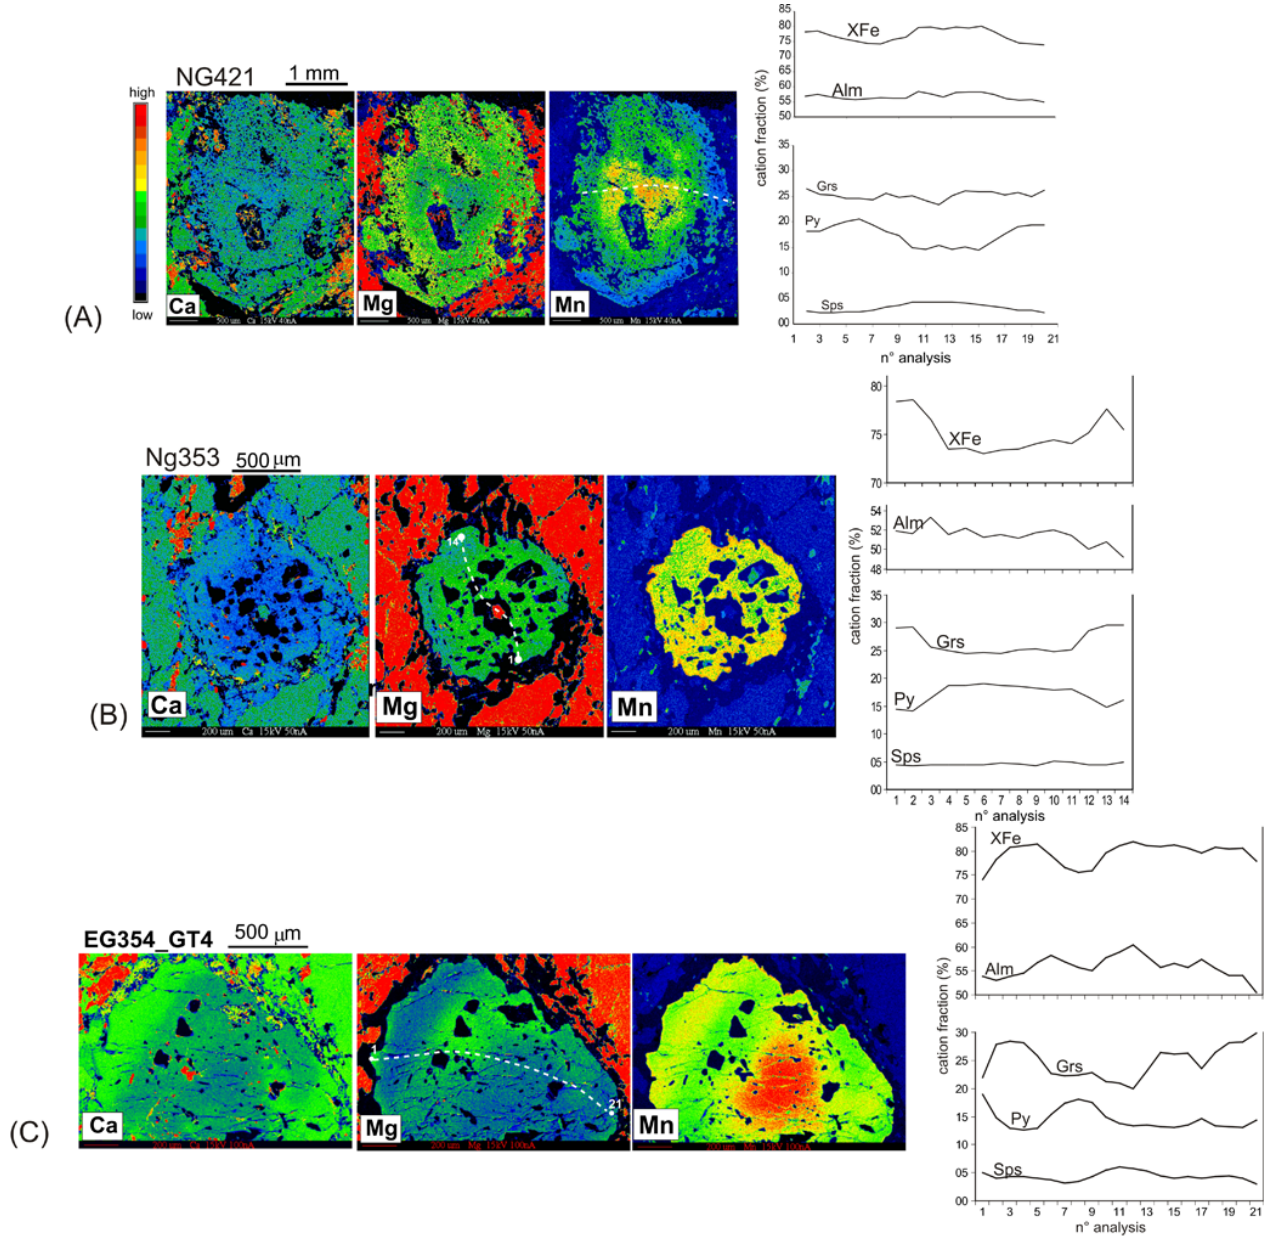
Fig. 9. Left: representative qualitative compositional cation map and quantitative cation profiles showing the variation in cation (Mg, Fe, Ca, Mn) distribution in garnets from the Sabzevar granulites. Noteworthy features are the rimward increase in Ca (grossular) and Mn (spessartine, Sps) and decrease in Mg (pyrope), which are indicative of retrograde diffusion and resorption. Alm, almandine; Grs, grossular; Py, pyrope; Sps, spessartine. Right: garnet compositions as obtained through EMPA chemical profiles across the same garnet grains (dashed white